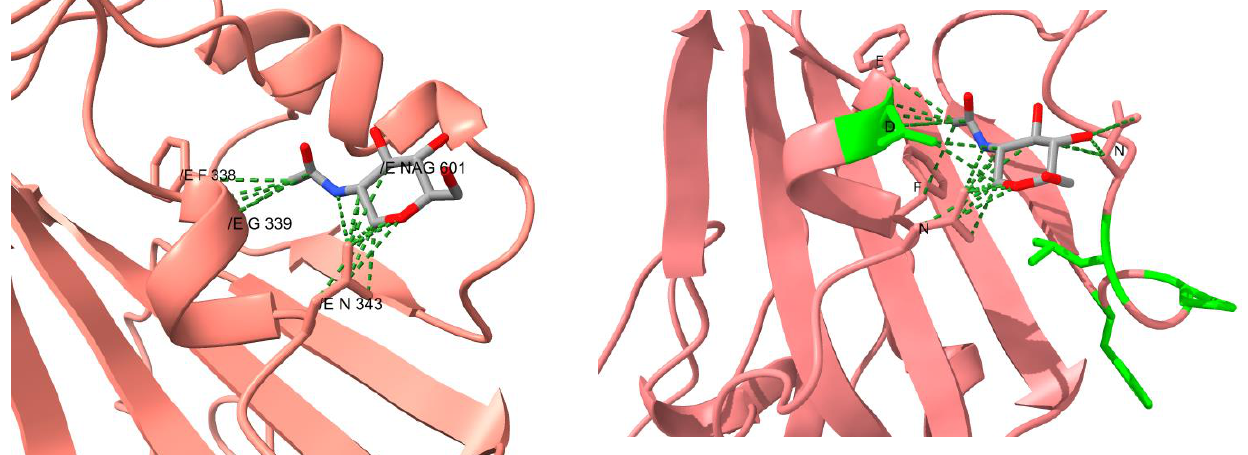
Figure 4. Comparison of the contacts at the glycosylation site N343 from the reference structure and of Omicron’s RBD. The carbohydrate in the reference structure is colored in light blue. The residues highlighted in green lime in the RBD of Omicron are the mutated residues.